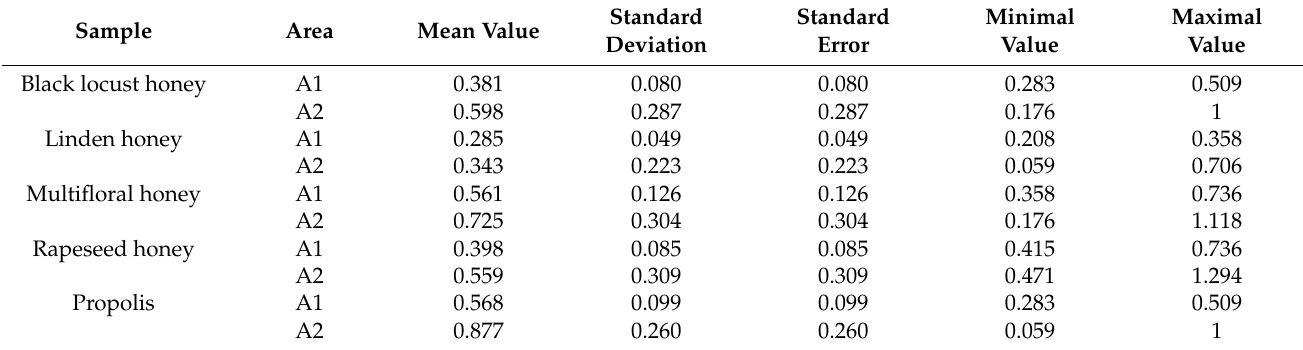
Table 15. Bioconcentration factor for p , p (cid:48)